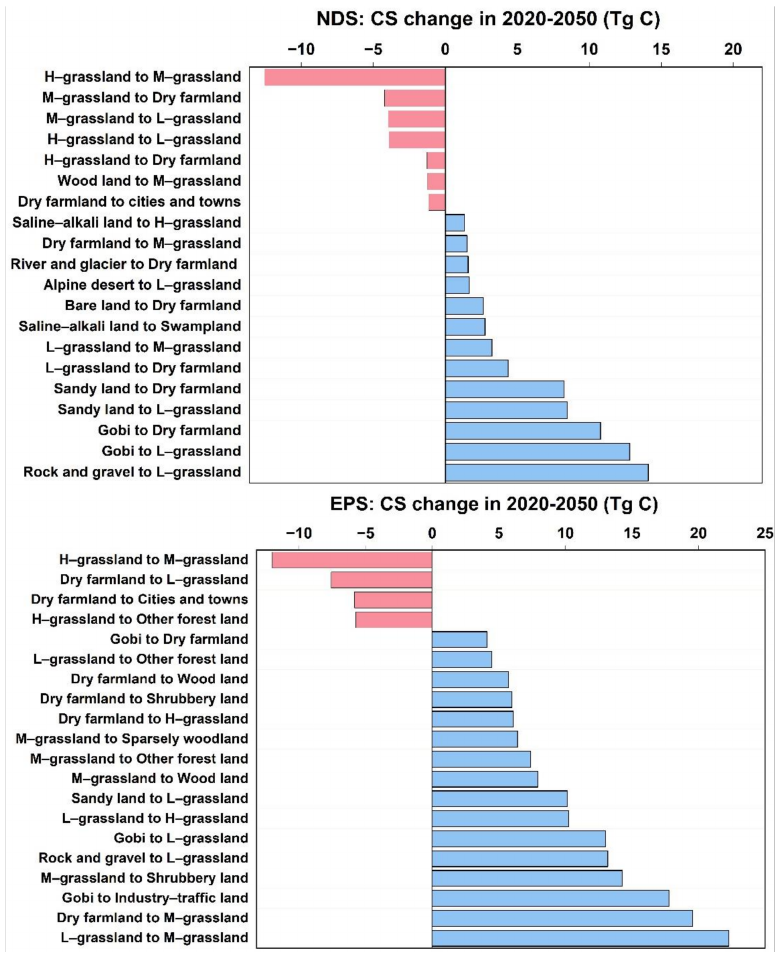
Figure 9. The major LUTC for CS change under NDS and EPS scenarios from 2020 to 2050 in the Gansu